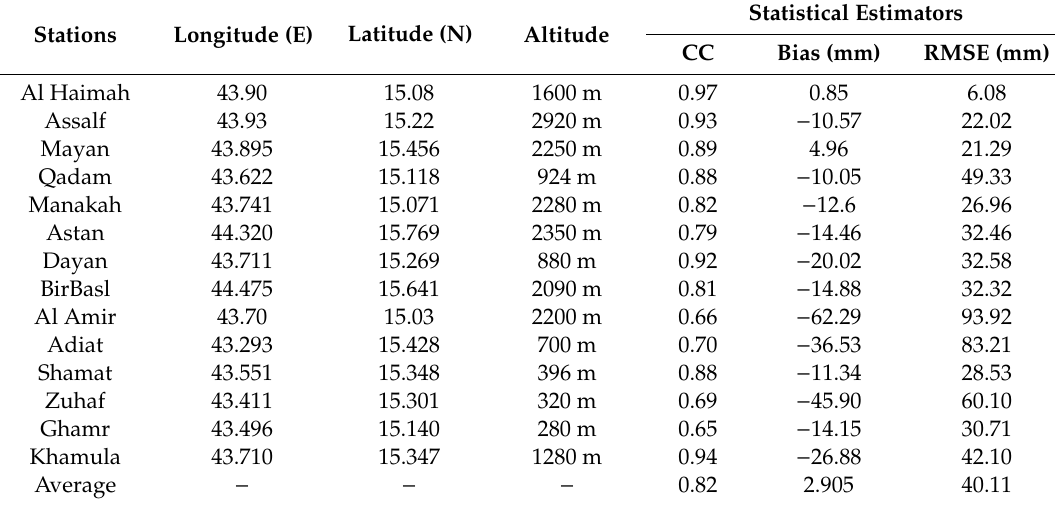
Table 7. Performance of CHIRPS with observed monthly rainfall rates from 14 stations over the highland region of Al Mahwit and Sana’a governorate.